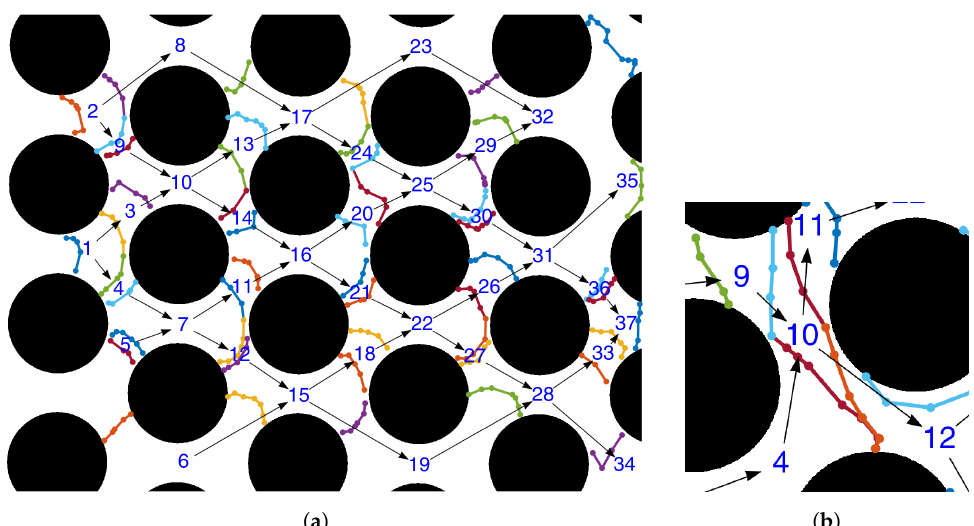
Figure 7. The transport network of the field of view where throats are labeled according to the branch number. The branch numbers are shown in the middle of a throat and each arrow is an evolution. Fluid flows from the left to the right. ( a ) transport network (for the 1500mbar experiment); and ( b ) branch 10 is nuclear with parents 4, 9 and children 11, 12 (in the 150mbar